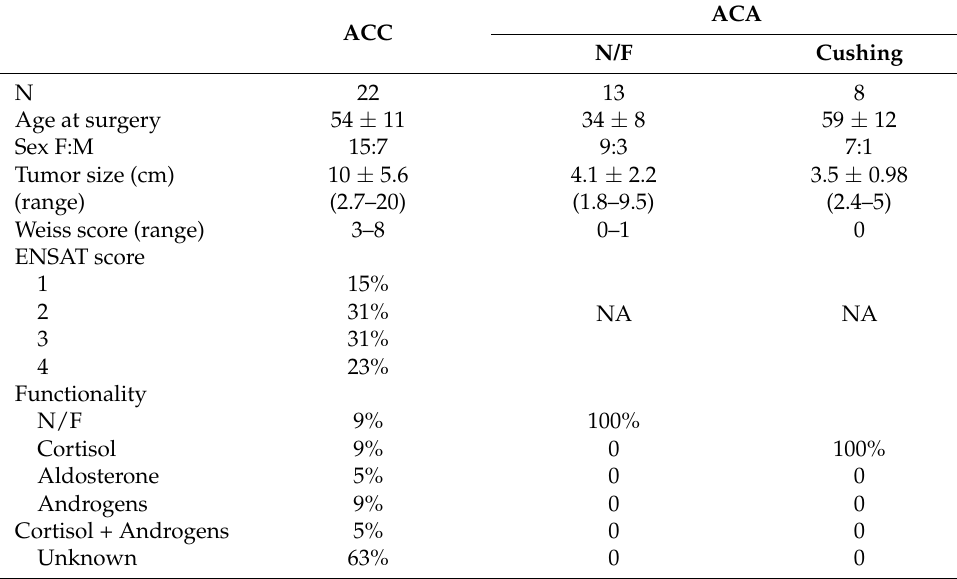
Table 4. Patients’ and tumors’